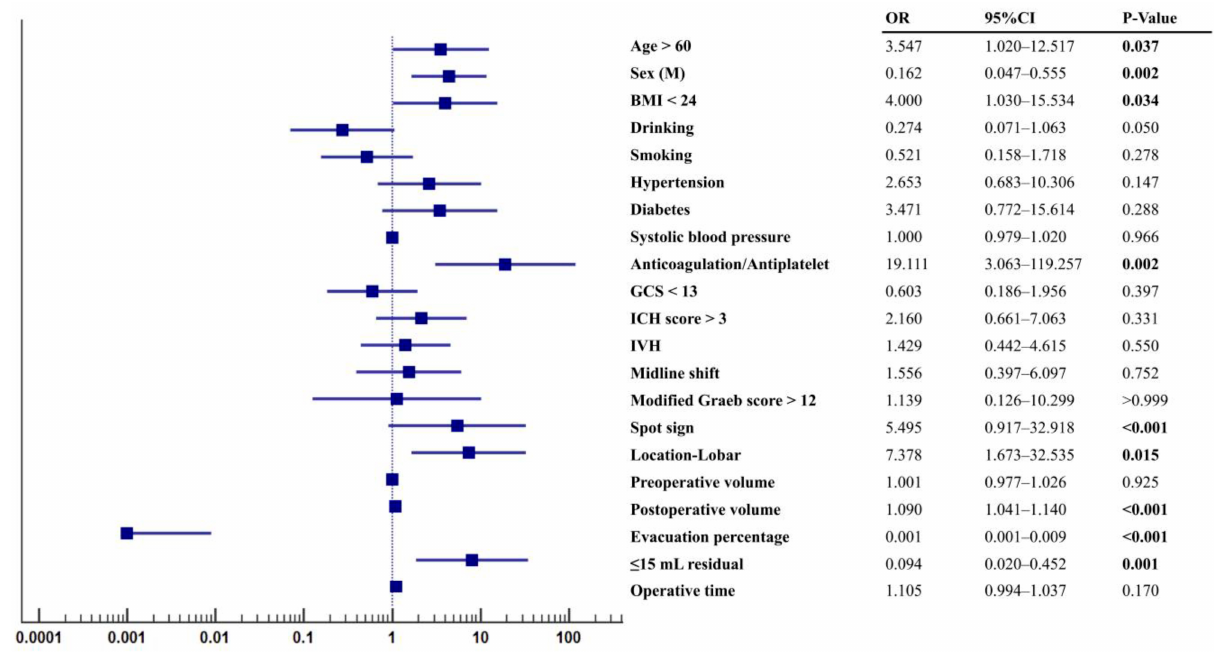
Figure 2. Odd ratios for patients with rebleeding. Statistic differences were analyzed by univariate regression analysis.